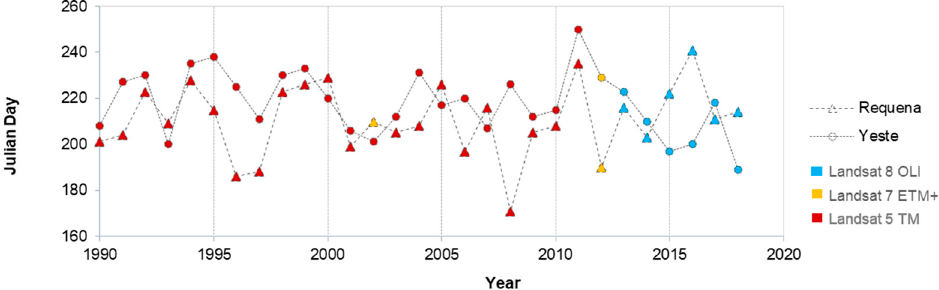
Figure 3. Scene selection dates according to the Julian Day.